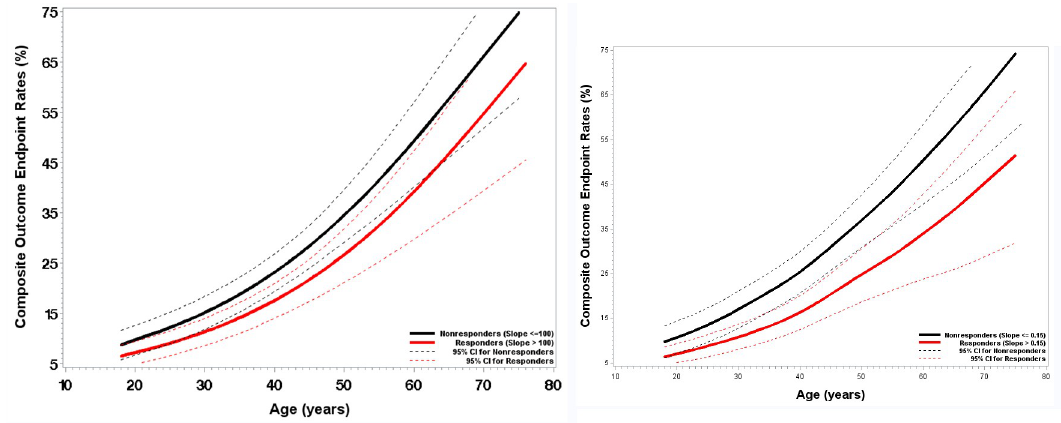
Fig 2. Smoothed cumulative composite outcome endpoint rate curves and their 95% confidence intervals at 10 years from ART initiation by age and immune status (2a: CD4 recovery status; 2b: CD4/CD8 ratio recovery status).